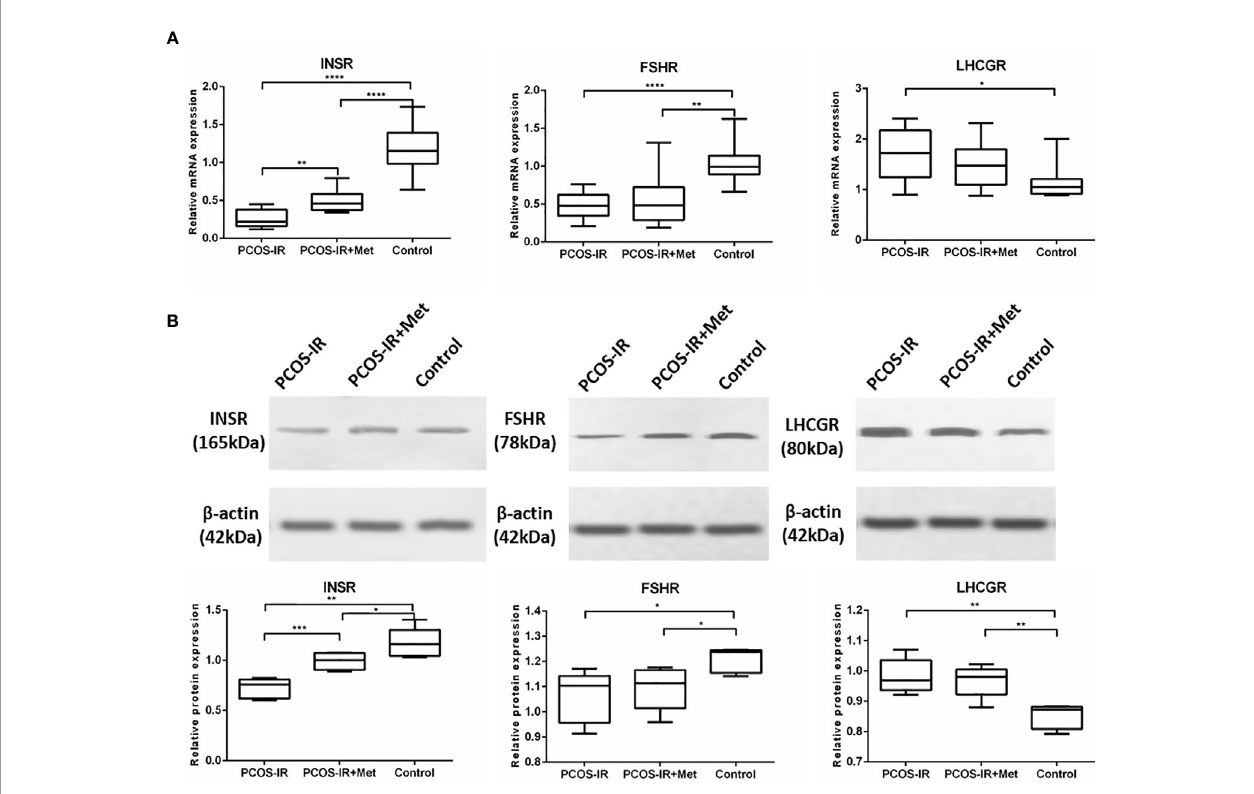
FIGURE 4 | The effects of metformin on INSR, FSHR, and LHCGR expressions in female F1 offspring. (A) INSR mRNA expression in pancreas, FSHR and LHCGR mRNA expression in ovaries following treatment with metformin or placebo as measured by RT-qPCR (PCOS-IR group, n = 9; PCOS-IR+Met group, n = 10; Control group, n = 10). (B) INSR protein expression in pancreas, FSHR and LHCGR protein expression in ovaries following treatment with metformin or placebo as measured by Western Blotting (PCOS-IR group, n = 5; PCOS-IR+Met group, n = 5; Control group, n = 5). The values were shown as the means ± SD. *p < 0.05, **p < 0.01, ***p < 0.001, ****p <